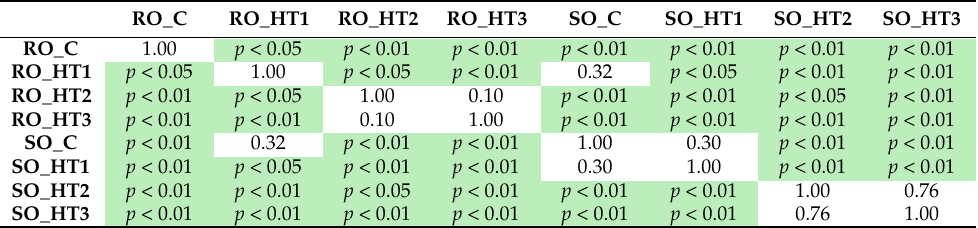
Table 4. Matrix with the p -values of the Hotelling’s T 2 tests for each pair of fortified oil groups (hedonic